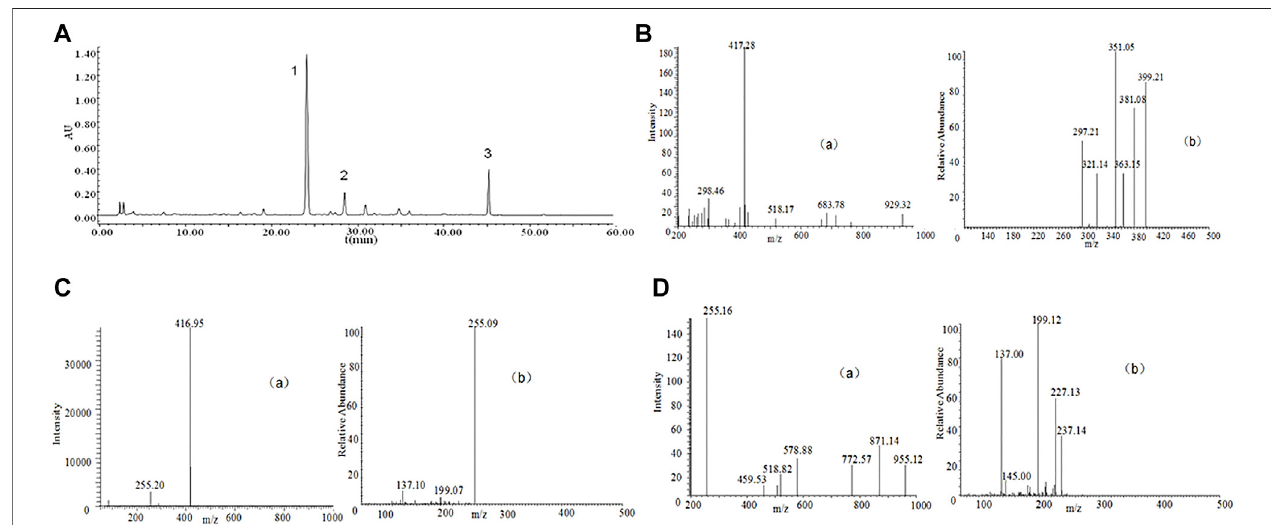
FIGURE 1 | High-performance liquid chromatography (HPLC) chromatograms and total ion chromatogram (TIC) of HPLC-electrospray ionization (ESI)-mass spectrometry(MS)of P.lobate Radixextract. (A) HPLCchromatogramsof Puerarialobate Radixextract (B) ESI-MS(a)andsecondary massspectrumofPuerarin(b) (C) ESI-MS(a) and secondary mass spectrum of Daidzin (b); (D) ESI-MS(a) and secondary mass spectrum of Daidzein (b). HPLC peaks were as follows: 1, Puerarin; 2, Daidzin; 3, Daidzein. Column: C18 column (250 × 4.6 mm id, 5 μ m). Column temperature 25 ° C; mobile phase: consisted of acetonitrile (solvent A) and water containing 0.5% phosphoric acid (solvent B),The P. lobate Radix extract was analyzed using the following agradient program: 0 – 5 min, 85 – 85%B; 5 – 10 min, 85 – 75% B; 10 – 20 min, 75 – 70% B; 20 – 35 min, 70 – 55% B; 35 – 40 min, 55 – 45% B; and 40 – 60 min, 45 – 45% B; fl ow rate: 0.8 ml/min; and detection wavelength at 250 nm. MS analysiswasperformedusingaDADinstrumentbyanESIinterface. Themassspectrometerwasoperatedinpositiveionmodes.Thecapillaryvoltage wassetat − 20 V. The spray voltage was set at 4.5 kV, and the capillary temperature at 250 °